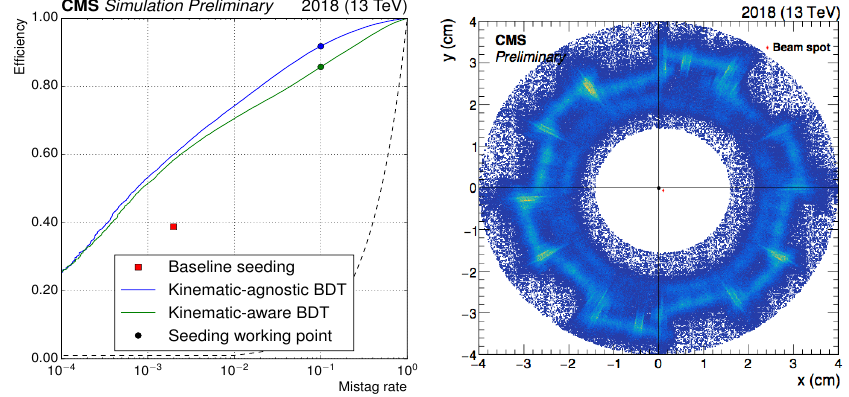
Figure 4. Left panel: ROC curves for a "kinematically agnostic" BDT (green curve) and a model- dependent "kinematically aware" BDT (blue curve), obtained from simulated B + → K + e + e − events. Var- ious working points, described in the text, are also indicated. Right panel: Vertex positions of photon conversion candidates in the transverse plane for the region | η | < 1. Taken from Ref. [25].